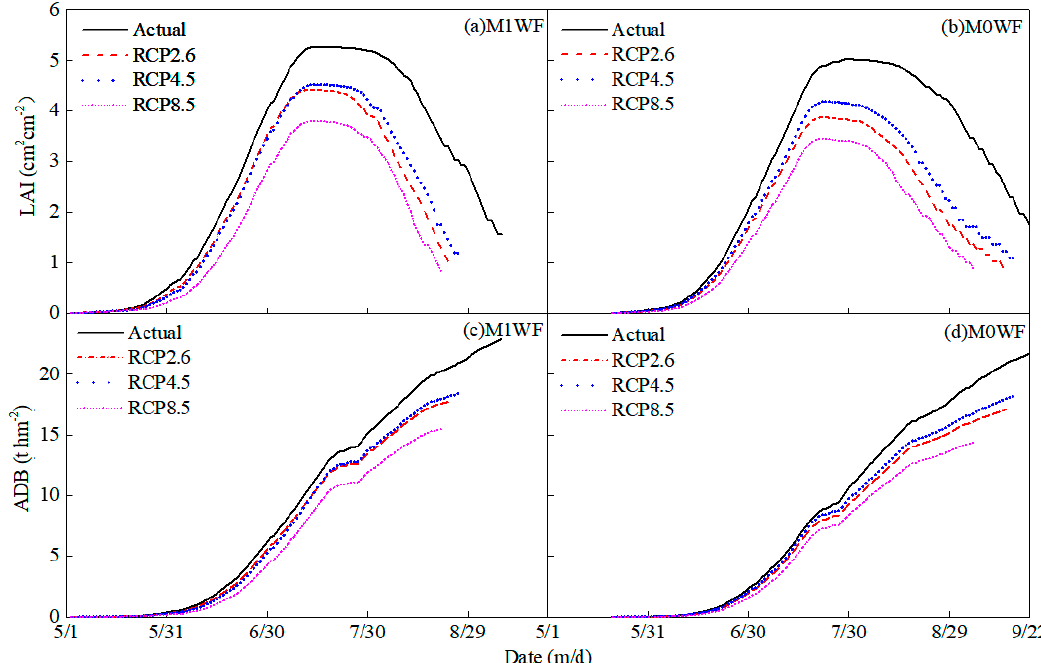
Figure 7. The LAI and ADB of seed-maize under the three RCPs scenarios in 2050. ( 1 Actual means the values in 2017.). Table 10. The seed-maize yield and ET under climate change scenarios in